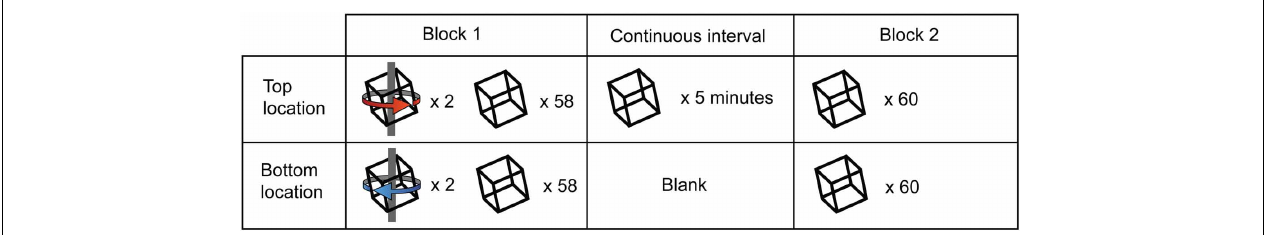
FIGURE 5 | Illustration of experiment 2 design. All sessions began with a block of 120 trials, of which 4 out of the first 8 (2 at each retinal location) were unambiguous. Observers were then presented with an ambiguous stimulus at either the top or bottom retinal